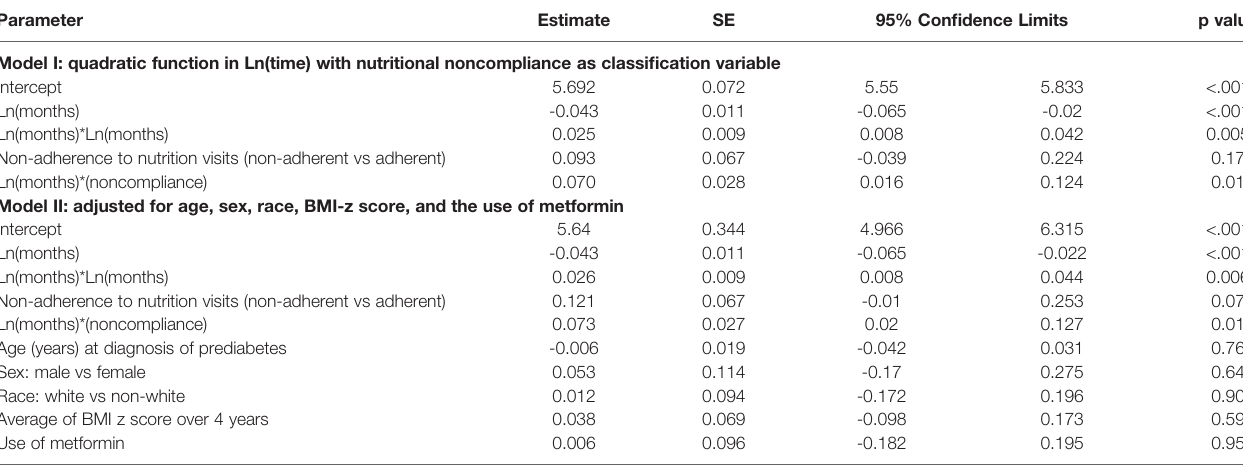
The trend analysis was based on generalized linear regression with gamma distribution and identity link function. Generalized Estimating Equations (GEE) was applied to account for autocorrelationwithinsubjectsoverthestudyperiodof48months.Signi fi cantparameterestimatesinLn(months)andLn(months)*Ln(months)indicateanoverallquadratictrendinHbA1c